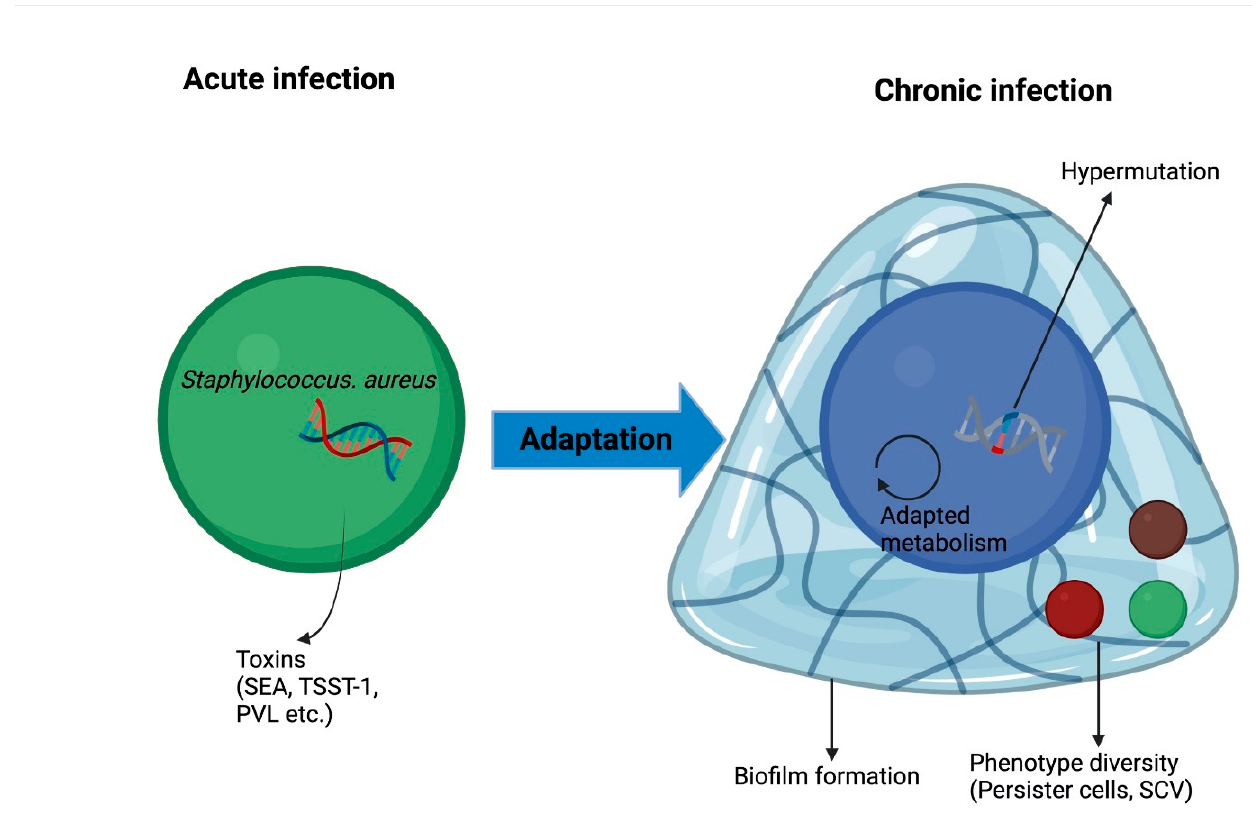
Figure 3. Adaptation mechanisms of S. aureus in lung environment leading to chronic infection. PVL, Panton-Valentine leucocidin; SEA, staphylococcal enterotoxin A; SCV, small colony variants; TSST-1, toxic syndrome toxin.